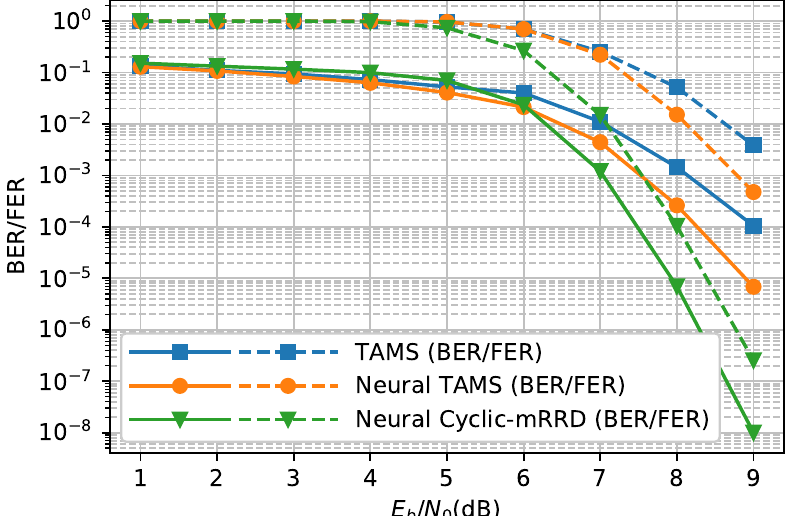
Figure 13. BER/FER performance of different decoders for the (263,132) QR